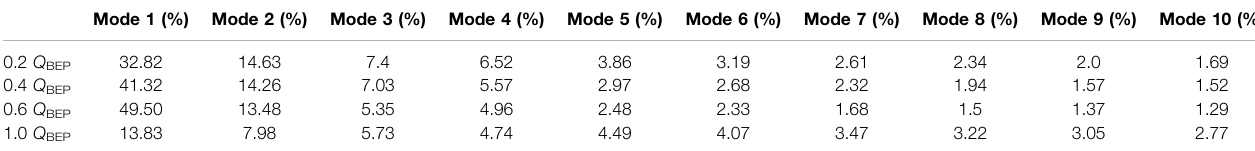
TABLE 2 | Speci fi c values for the fi rst 10 modes.